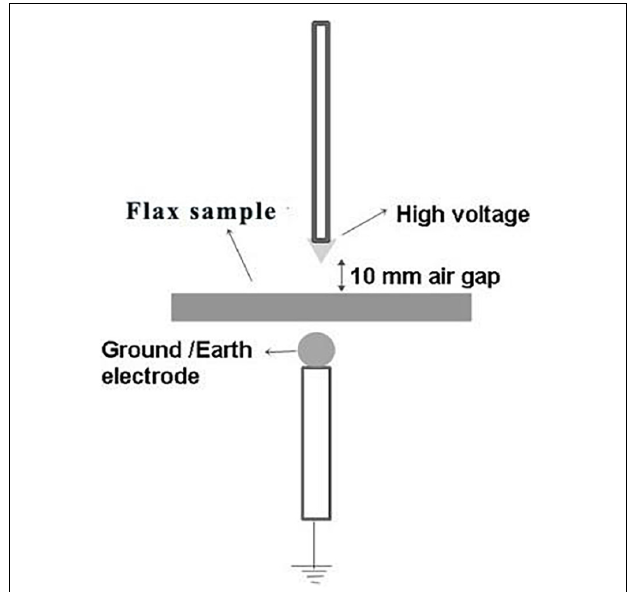
FIGURE 5 | Illustration of a lightning experimental setup.